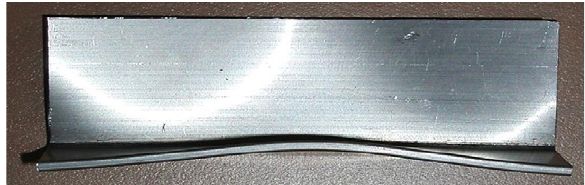
Figure 10. Example of failed stiffener test specimen in local buckling mode